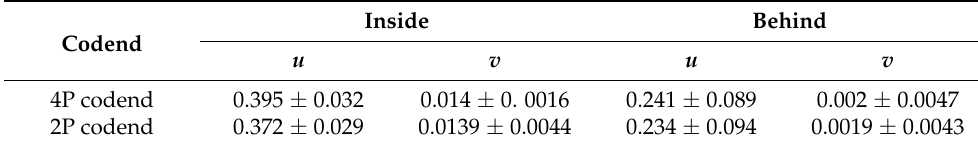
Figure 14. Time evolution of the streamwise velocity ( right ) and transverse velocity ( left ) linked to the normalized frequency spectrum (bottom in a log-log scale) behind the different codends. Table 4. Mean flow velocities of the two